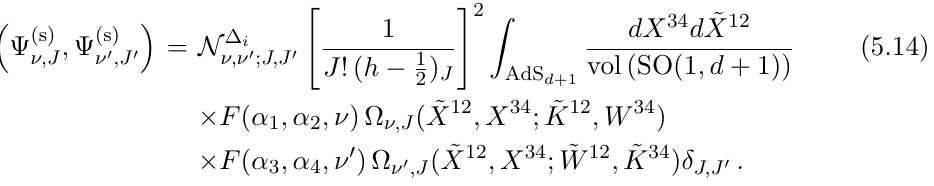
Figure 5 . The summary of the calculation of (cid:4) (cid:11) 1 ;(cid:11) 2 ness of the AdS harmonic functions, a loop of harmonic functions can be expanded as a series of harmonic functions and due to the orthogonality, (cid:12)nally, it is proportional to a single harmonic func-